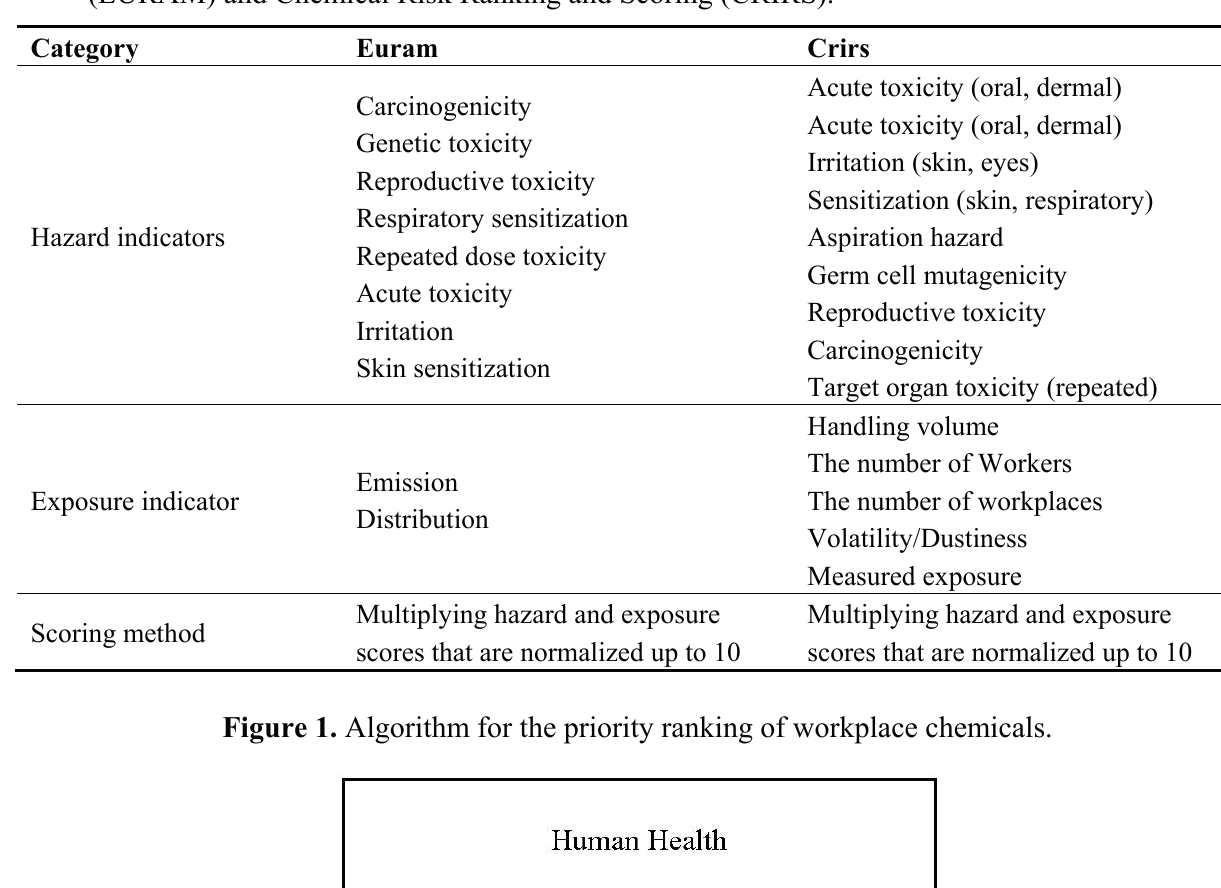
Table 1. Indicators and scoring methods of European Union Risk Ranking Method (EURAM) and Chemical Risk Ranking and Scoring (CRIRS).